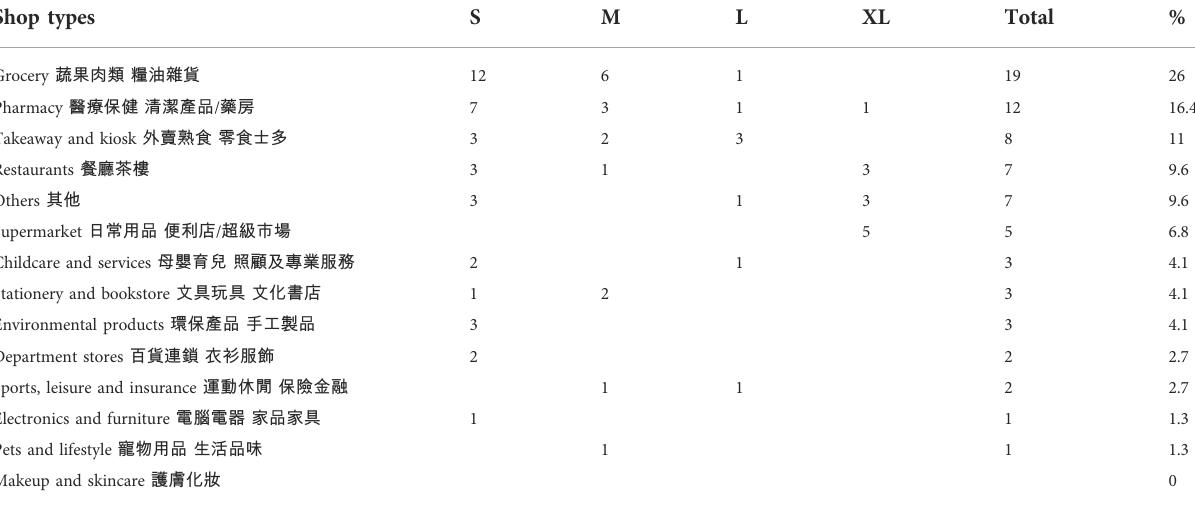
TABLE 1 Players ’ selected shop types and